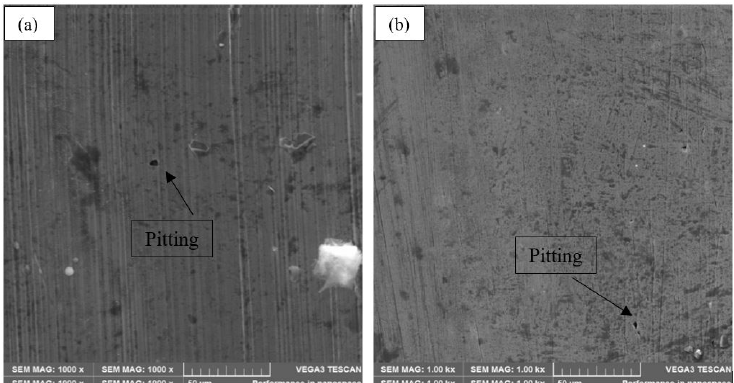
Figure 19. Samples of tests 4 (a) and 4P (b) with 1000X